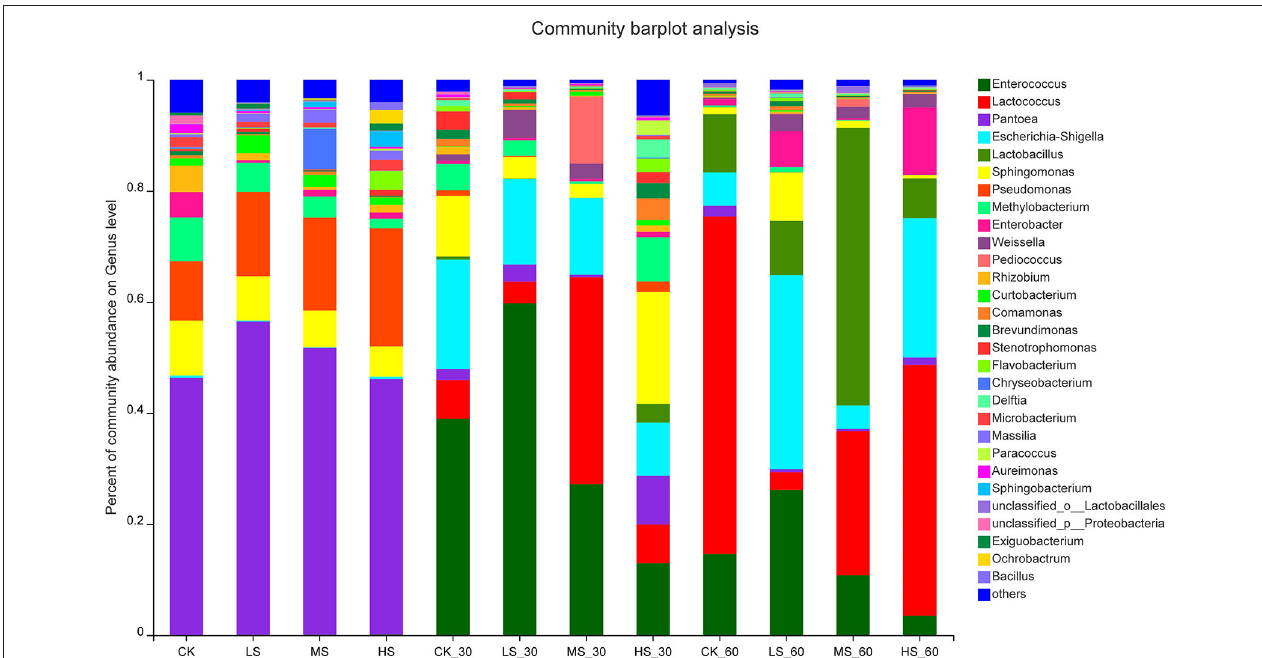
FIGURE 2 | Bacterial community composition on genus level in alfalfa silage. CK, fresh material of alfalfa without salt stress; LS, alfalfa under light salt stress; MS, alfalfa under moderate salt stress; HS, alfalfa under severe salt stress; 30, 30 days of ensiling; 60, 60 days of ensiling.